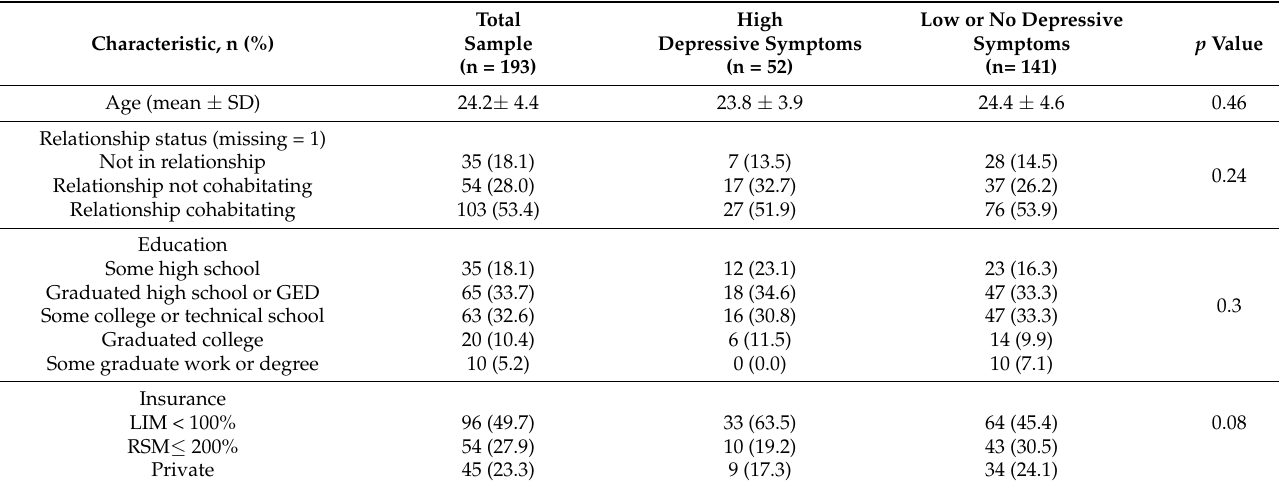
Table 1. Demographic characteristics of African American women by high and low or no depressive symptoms (using EDS cutoff ≥ 10).